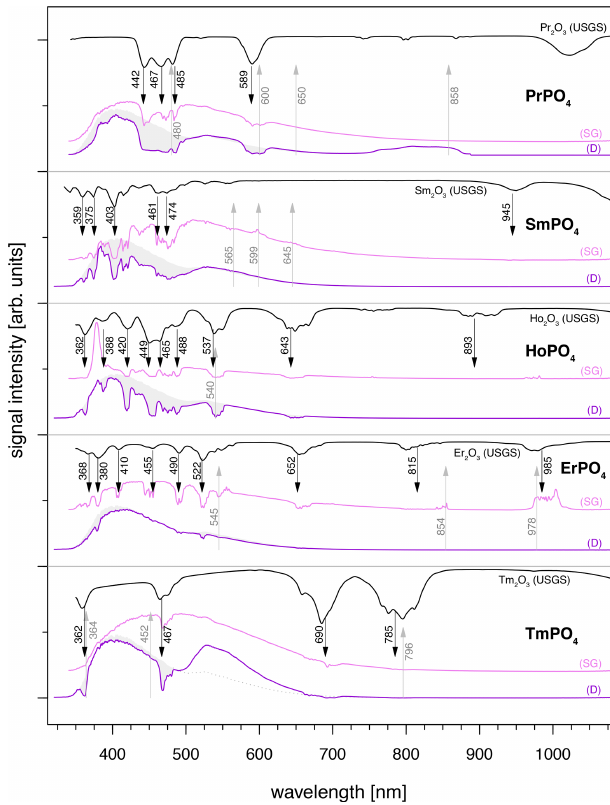
Figure 5. REE spectra illustrating diagnostic absorption features within prominent broad-band emissions at wavelengths < 800nm and REE emission lines for those > 650nm. Violet and pink LiF spectra were measured using laser excitation at 325nm for both sample specimens ( D : samples embedded in disc; SG: single grain samples). Grey shaded area represents epoxy resin mean spectrum expected for D samples without absorption features. Emissions > 650nm are better visible in SG samples due to the lower intensity of the broad-band luminescence. Black reflectance spectra depict reference data from the USGS library (Kokaly et al.,